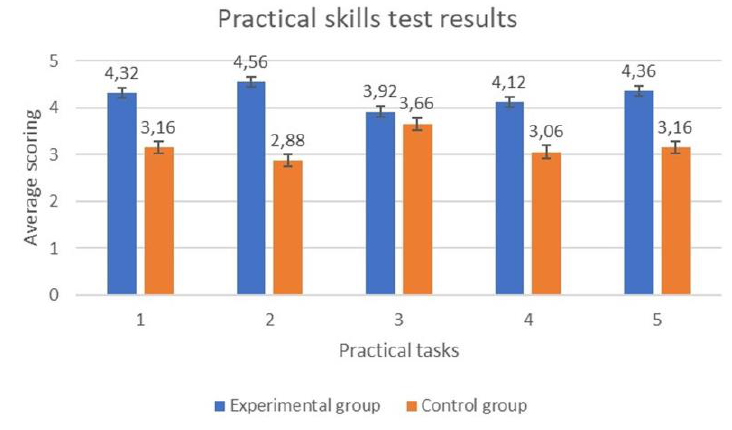
Fig. 4. Practical skills test